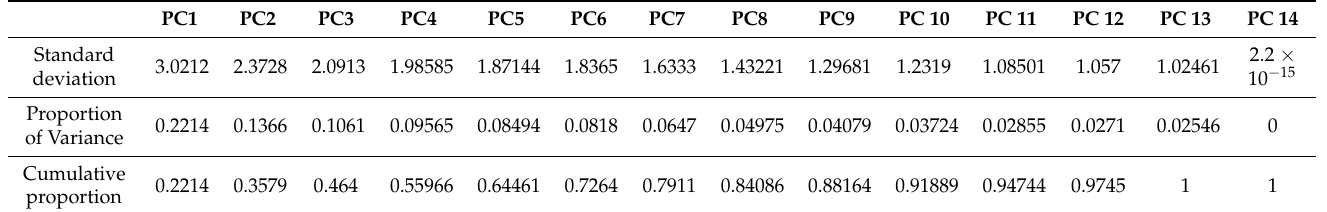
Figure 3. Minimal spanning tree based on Hemming Nei’s genetic distance for three groups of banana varieties. 3.5. Varietal Identification Using ISSR Markers Twelve ISSR markers with several polymorphic bands were amplified and used for varietal identification of locally-grown bananas. The varietal identification approach can be an efficient option in the practical utilization of ISSR markers in the complete and preferable identification of plant varieties. For identification of the 14 local banana varieties, the electro-photogram of 40 reproducible ISSR markers was carefully studied to look for unique reproducible bands which could identify banana varieties under study.